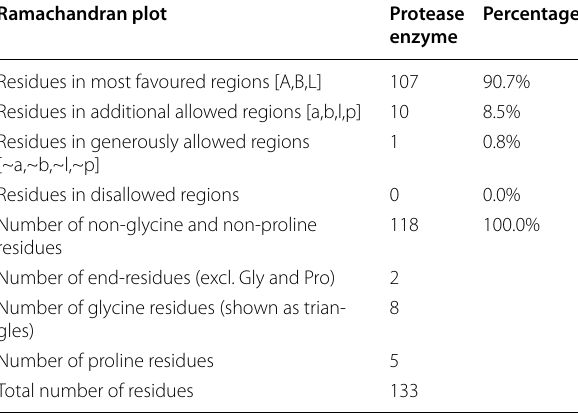
Percentage enzyme